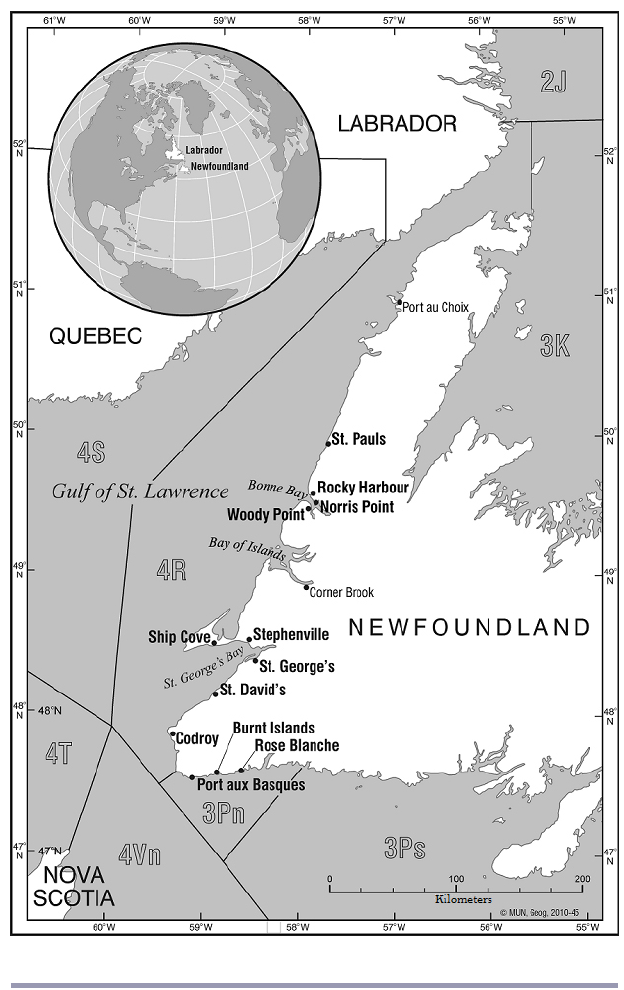
Fig. 1 . Map of the study area, which includes Northwest Atlantic Fisheries Organization divisions